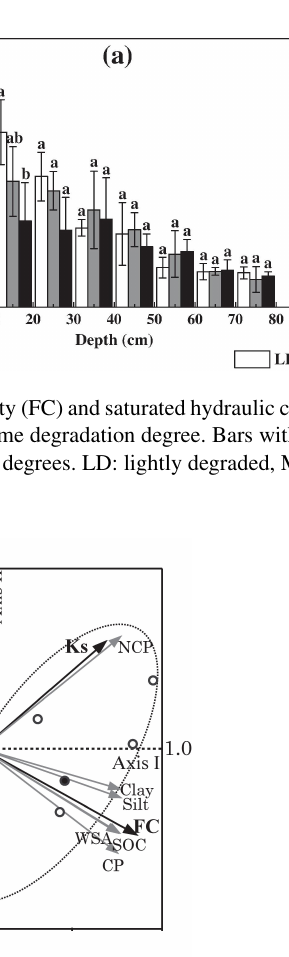
explain large proportions of the variance in FC and K s , the relative influence of other soil properties can be